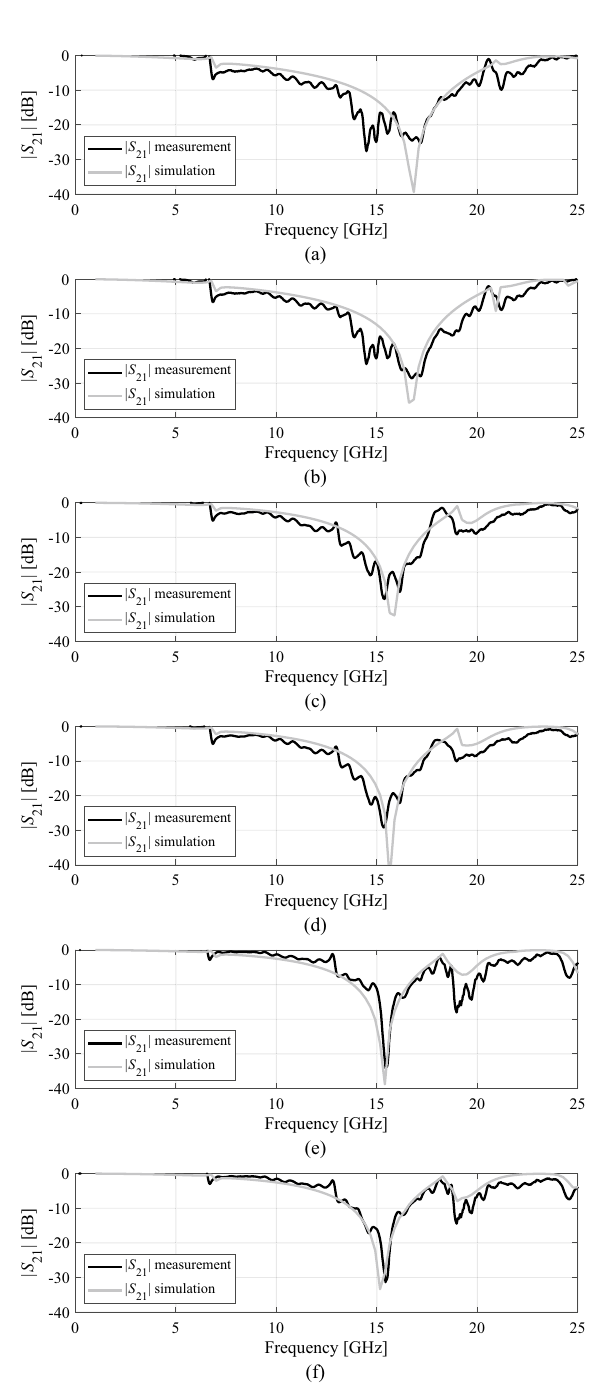
Figure 13. Measured and simulated results, ( a ) TE mode at 15°, ( b ) TM mode at 15°, ( c ) TE mode at 30°, ( d ) TM mode at 30°, ( e ) TE mode at 45°, ( f ) TM mode at